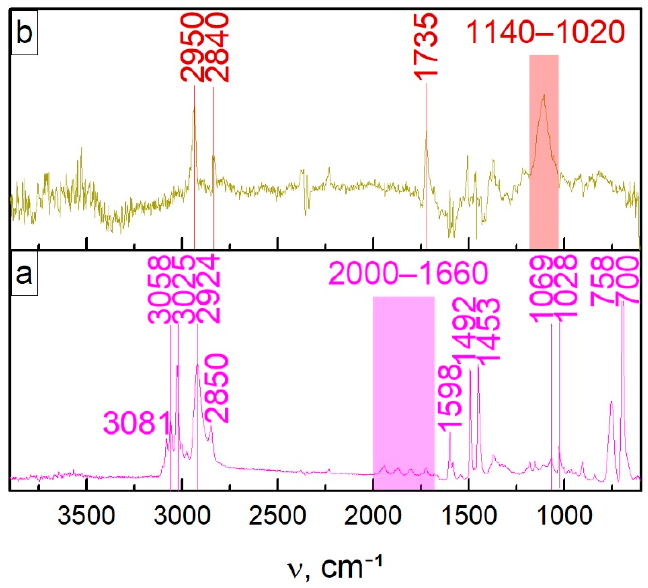
Figure 2. FTIR spectrum of composite 2 ( a ) and the difference in spectrum of the above composite and PS matrix ( b ).